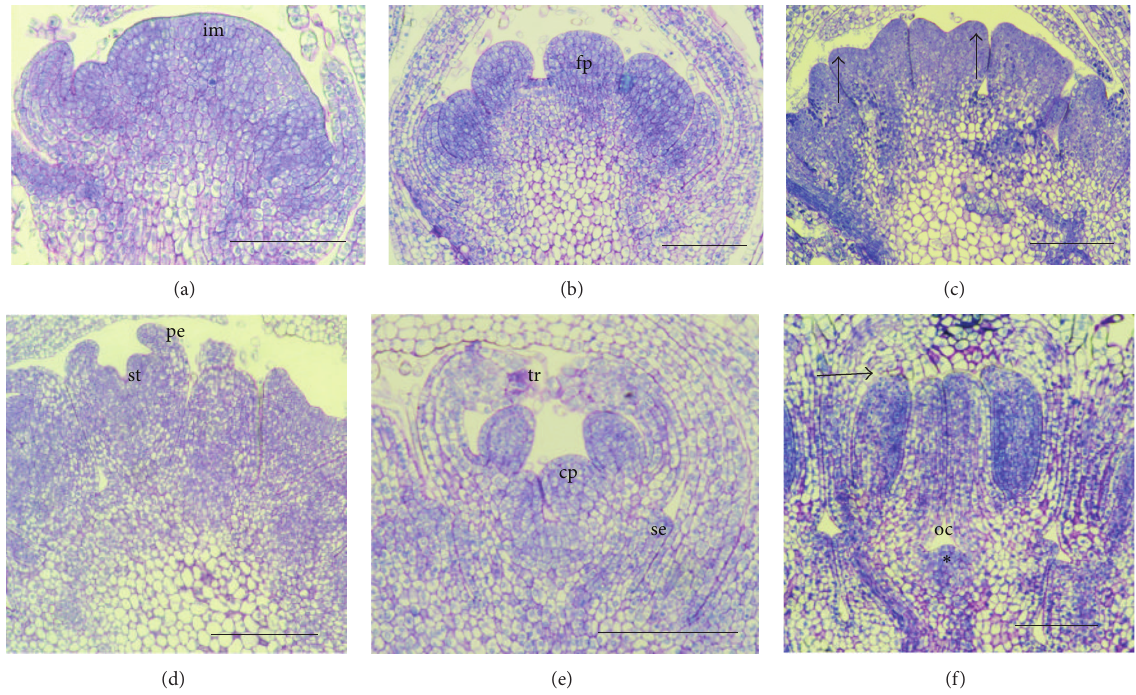
Figure 3: Flower organ initiation (stage 1–5). (a) Inflorescence meristem dome (im) is established. (b) Stage 1: the flower primordia (fp) emerge from the inflorescence meristem. (c) Stage 2: the petals are initiated at the margin of the flower primordium apex (arrows). (d) Stage 3: the stamen primordia (st) are initiated under the petals (pe). (e) Stage 4: the stamens are stalked, sepals (se) are initiated, the carpel lobes (cp) emerge, and trichomes (tr) develop at the top of the petals. (f) Stage 5: the carpel lobes and stamens grow and attain the same height (arrow). Ovary cavity (oc) is formed and ovule is being initiated ( ∗ ). Bars 100 𝜇